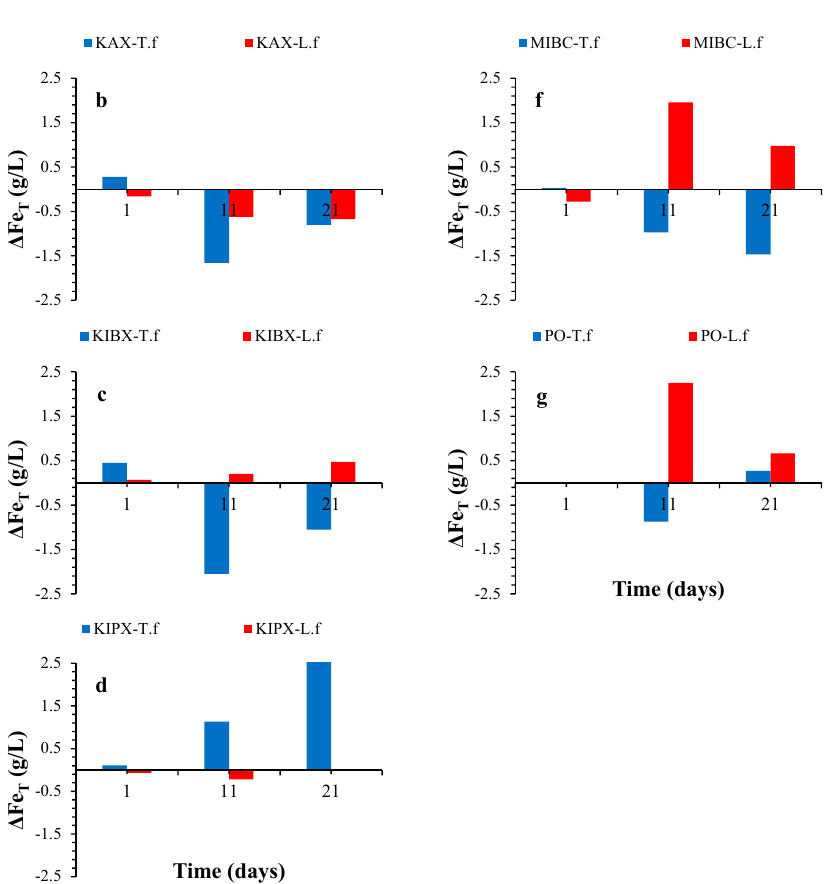
Figure 5. Effects of various flotation reagents on Fe T during L. ferrooxidans and A. ferrooxidans activities.